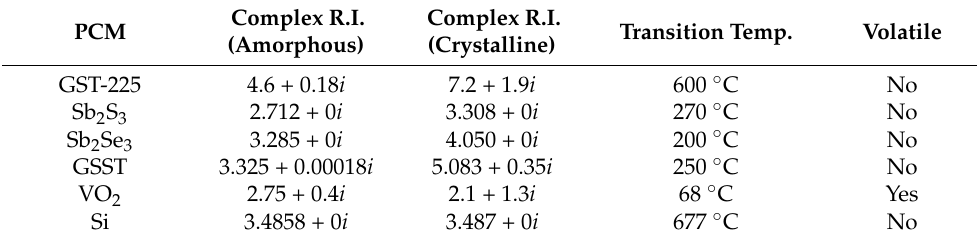
Table 1. Properties of some of the PCMs where complex refractive indices for amorphous and crystalline phases are calculated for the wavelength of 1550 nm. The source of data are from [23] for GST-225, [24] for Sb 2 S 3 and Sb 2 Se 3 , [25] for GSST, [26] for VO 2 , and [27–29] for Si. Complex PCM